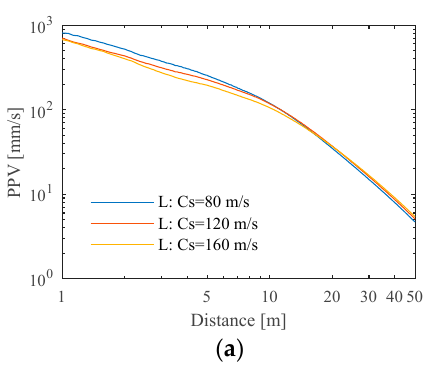
Figure 10. PPV versus distance from the pile due to impact pile driving for different ground stiffnesses: ( a ) linear analysis; ( b ) equivalent linear analysis.